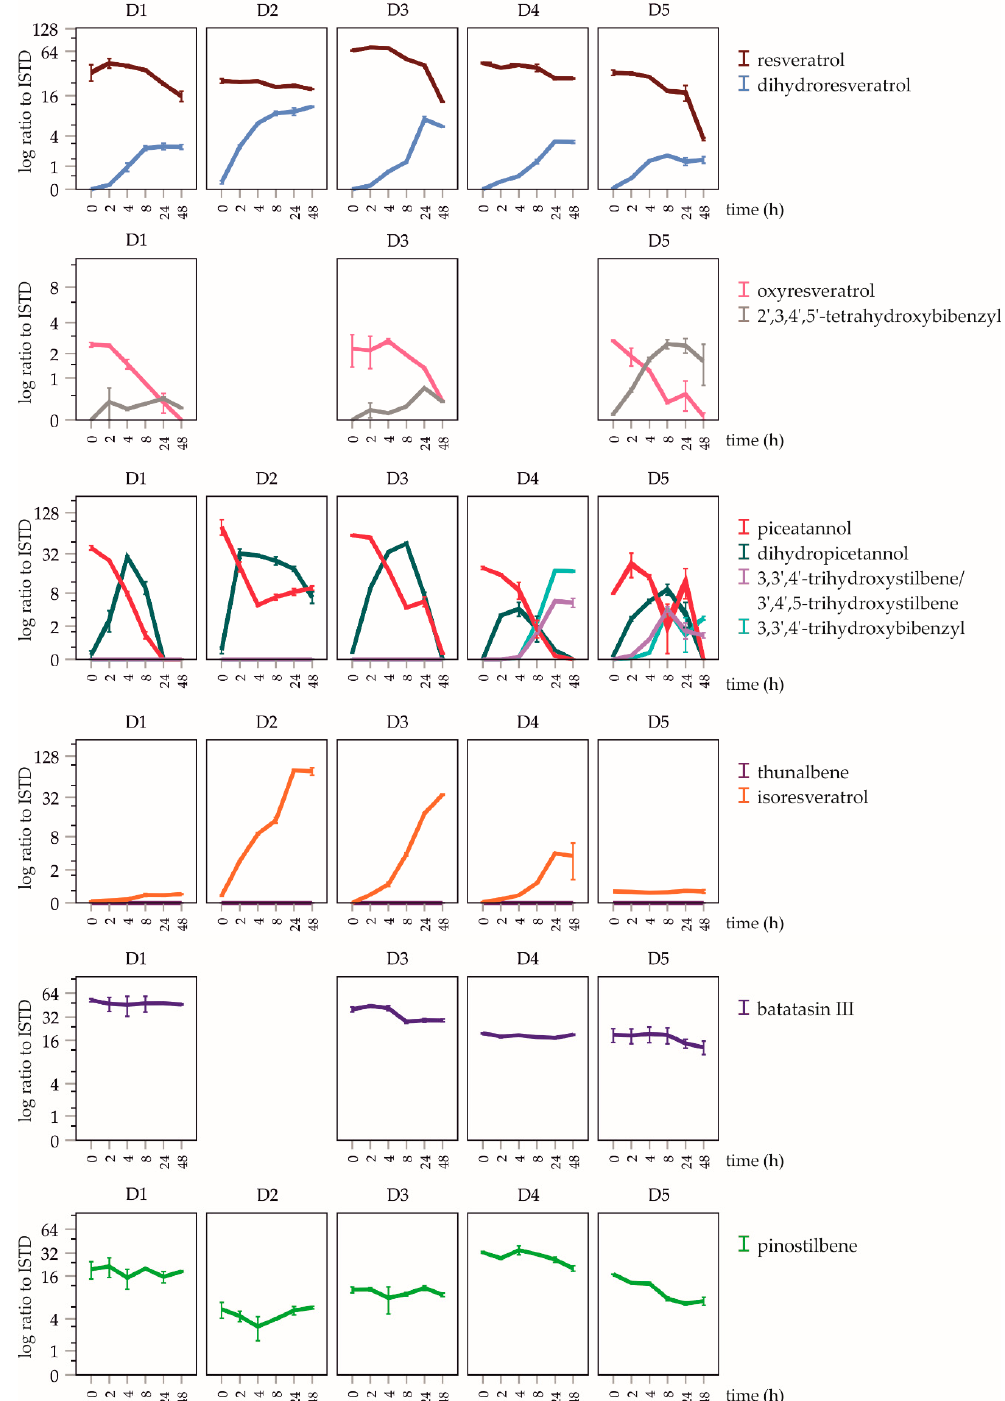
Figure A2. Comparison of metabolism between donors. Values are expressed as Means ± 1 SE, n = 3, technical replicates